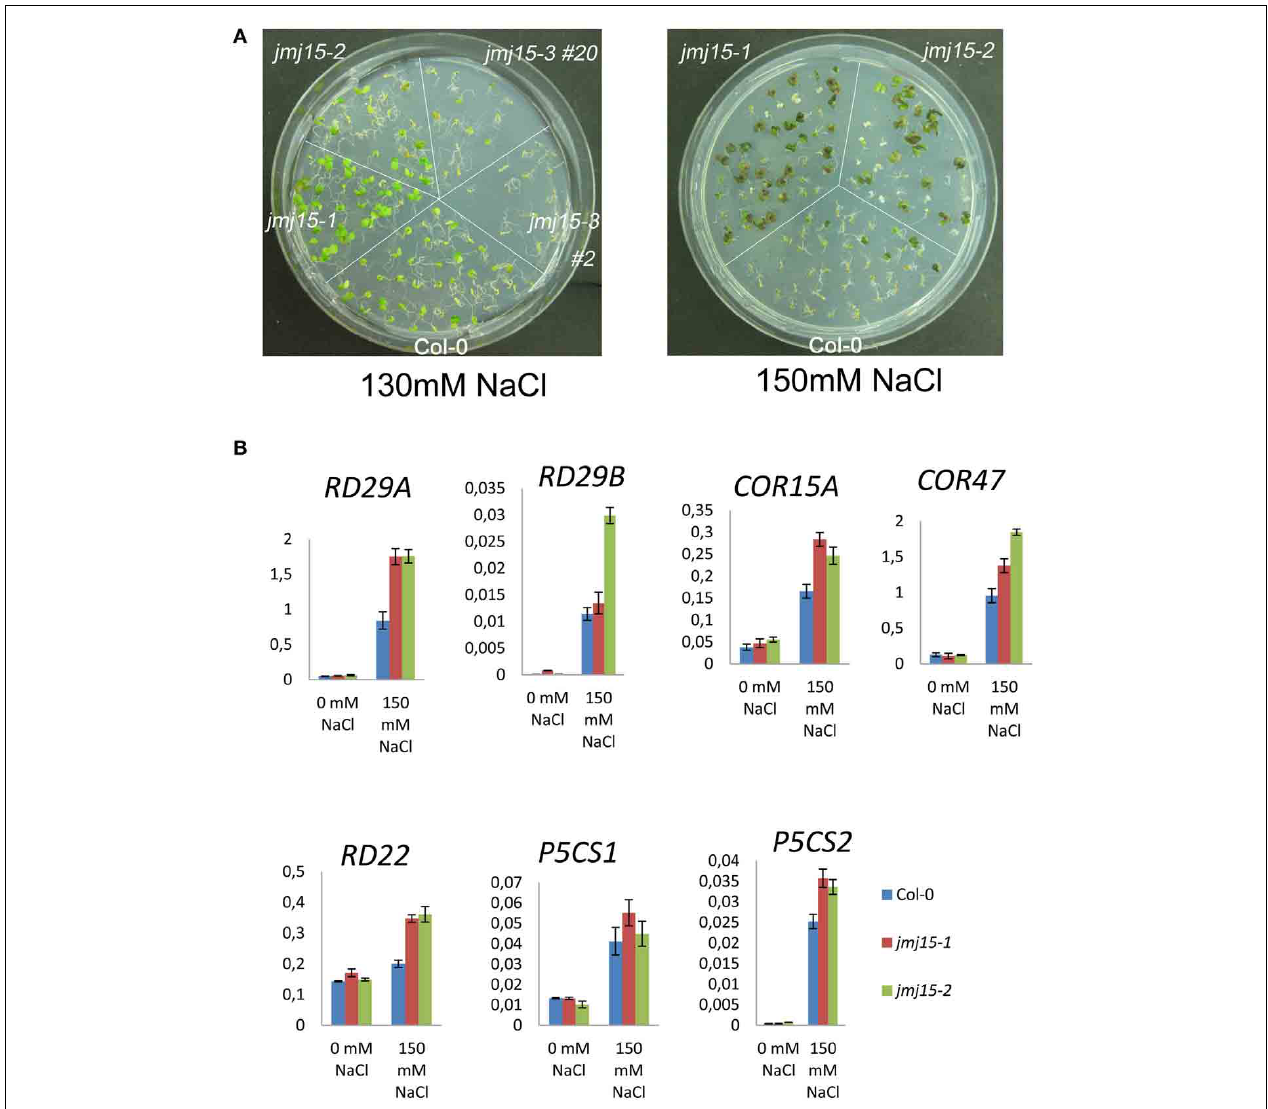
FIGURE 7 | Comparison of sensitivity to NaCl and stress-responsive gene expression between jmj15 mutants with wild type. (A) Wild type , jmj15-1 , jmj15-2 , and jmj15-3 seeds were germinated for 12 days on ½MS supplemented with indicated concentrations of NaCl. Images of the Petri